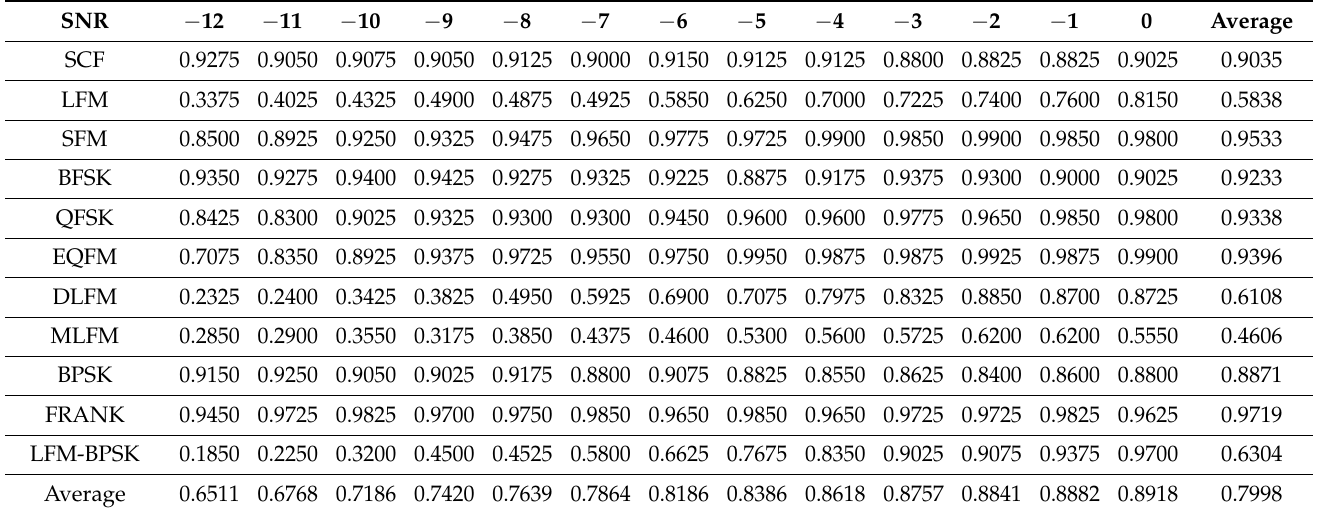
Table A21. Semi-supervised classification results with the datasets in Situation Dataset 5 ( d = 1 constant).